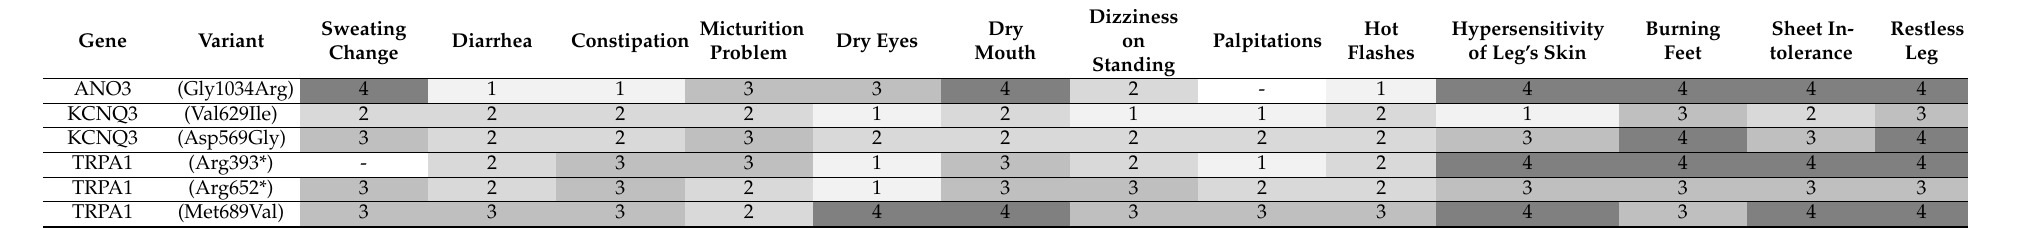
Table 6. Complaints reported in the Small Fiber Neuropathy Symptom Inventory Questionnaire (SFN-SIQ) by SFN patients carrying a variant in ICG.